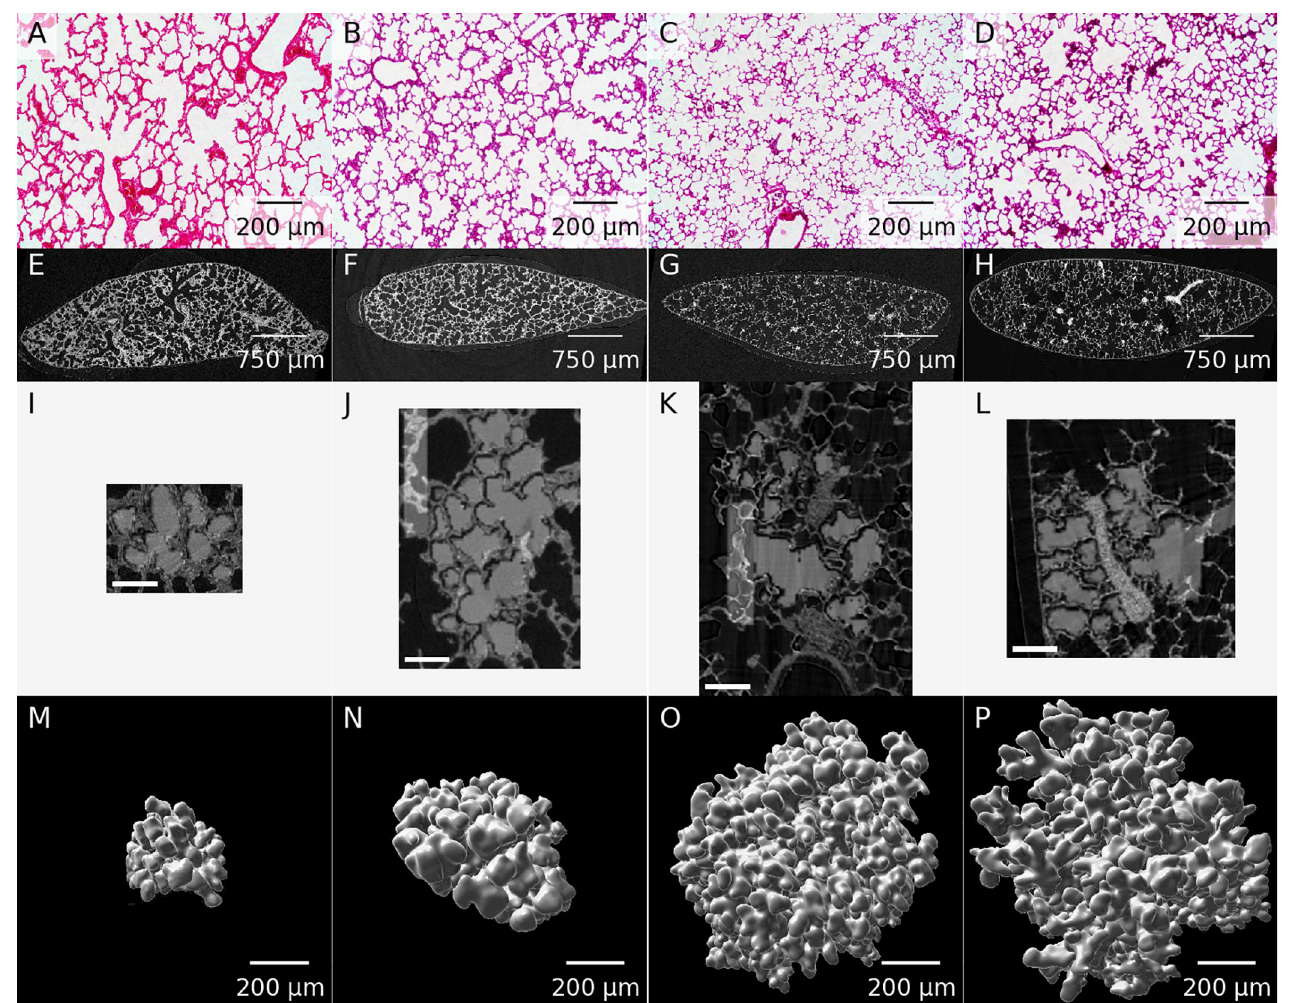
Fig 1. Example images for each of the assessed time points. A–D: Representative light microscopy images. E–H: One slice of the tomographic data sets. I–L: Middle slice of one of the extracted acini. The extracted acinus is overlaid on the tomographic dataset. Panels J and K also show the segmentation stopper at the left border of the image. The shown images correspond to the middle slice of the full data sets used for the stereological analysis. The scale bar was burnt in during preparation of the image stacks and is 100 μ m long. M–P: Three-dimensional visualization of one of the extracted acini. Panels A, E, I & M: Day 4. Panels B, F, J & N: Day 10. Panels C, G, K & O: Day 21. Panels D, H, L & P: Day